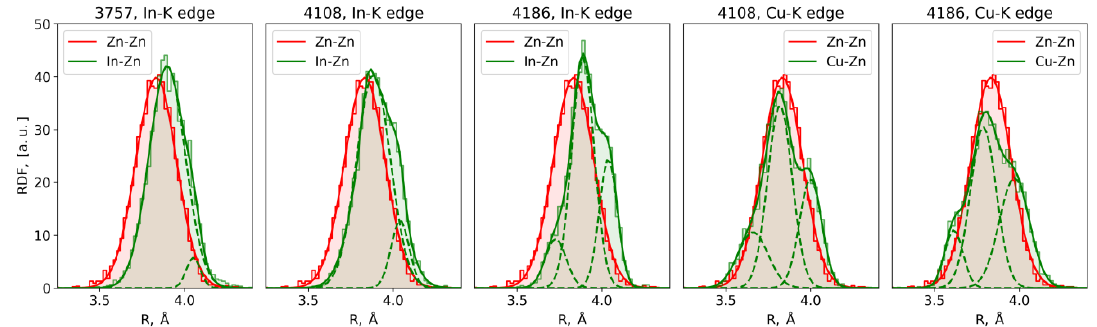
Figure 4. Comparison of Cu-Zn and In-Zn RDFs in doped sphalerites (green curves) with Zn-Zn RDF in pure sphalerite (red curve) derived from RMC-EXAFS fits.